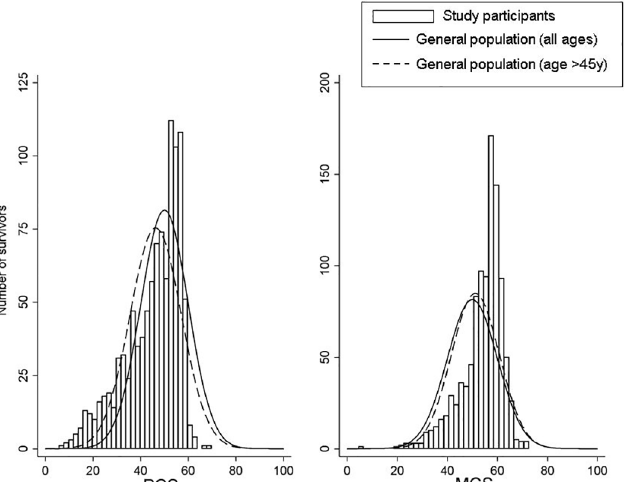
Fig 1. Distribution of Physical Component Summary (PCS) and Mental Component Summary (MCS) scores among survivors (black bars; bin width is 2 units), and normative reference populations. Solid line represents the US general population, with normal distribution with mean (standard deviation) of 50 (10). Dashed line represents the US population over age 45 years, with mean PCS 46.3 (10.8) and mean MCS 51.1 (9.6)[14, 15, 33]. Curves have been scaled such that the area under each is equal to the number of participants, 1,021, and the y-axis is the number of survivors in each